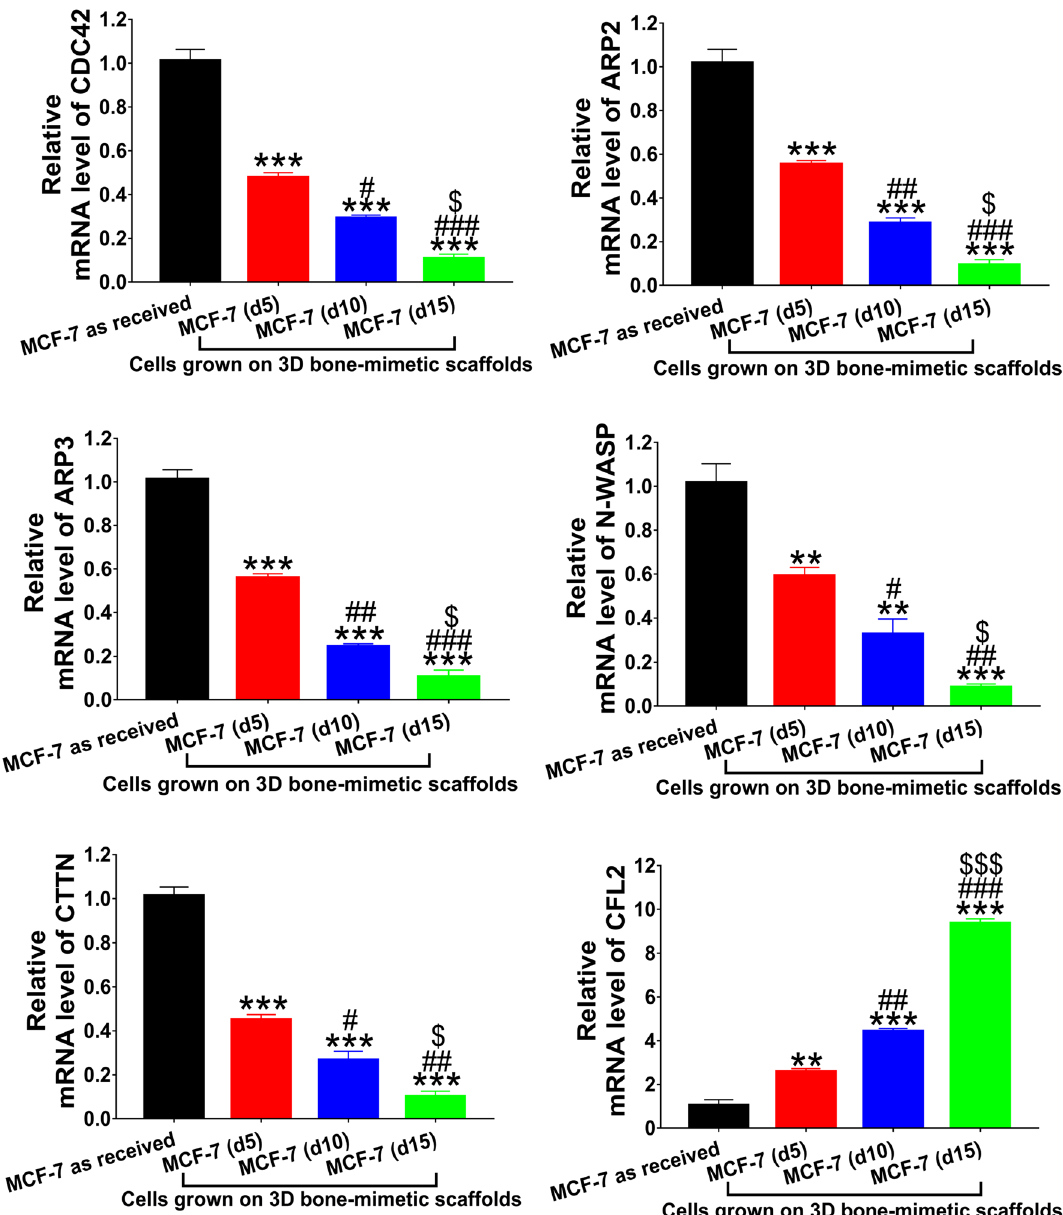
Figure 6. Quantitative real-time PCR of gene expression for actin dynamics-related genes CDC42, ARP2, ARP3, N-WASP, CTTN, and CFL2. *p < 0.05, **p < 0.01, and ***p < 0.001 indicate significant difference between MCF-7 as received and MCF-7 cells grown on 3D bone-mimetic scaffolds; # p < 0.05, ## p < 0.01, and ### p < 0.001 indicate significant difference between MCF-7 (d5) cells grown on 3D bone-mimetic scaffolds, and other MCF-7 cells grown on 3D bone-mimetic scaffolds (i.e., MCF-7 (d10) and MCF-7 (d15)); $ p < 0.05, $$ p < 0.01, and $$$ p < 0.001 indicate significant difference between MCF-7 (d10) and MCF-7 (d15) cells grown on 3D bone- mimetic